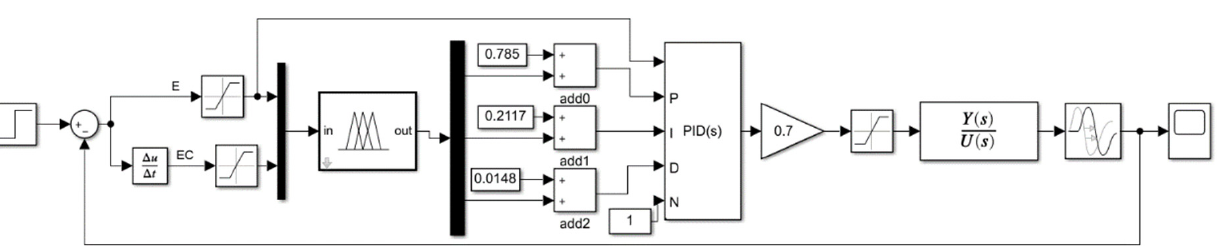
Figure 7. System simulation model.